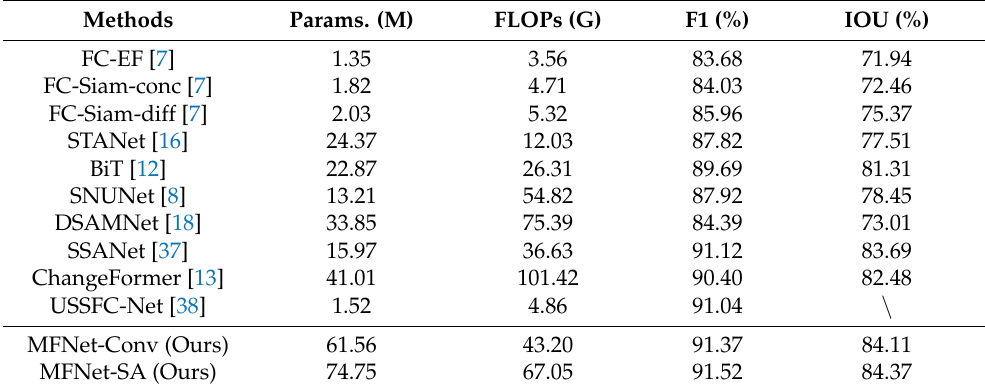
Table 10. Comparison of computational complexity and metrics on LEVIR-CD of different algorithms.